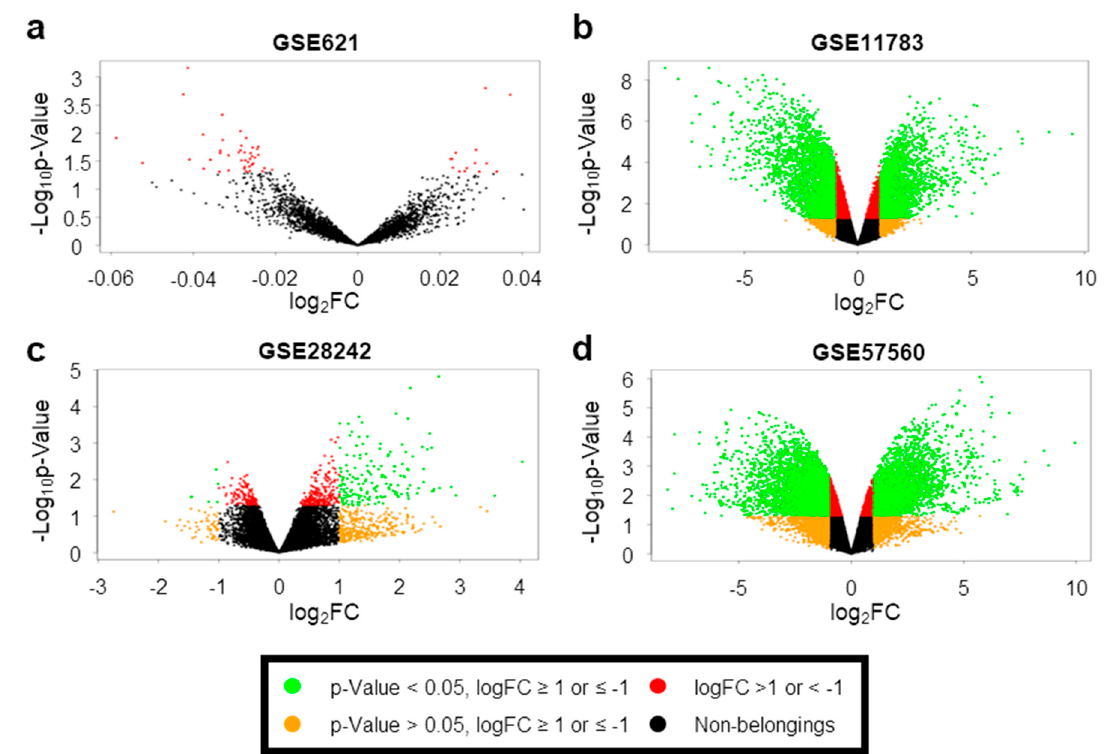
Figure 1. Analysis of significant genes in interstitial cystitis/bladder pain syndrome (IC/BPS). ( a – d ) Volcano plots show the transcript expression between normal and IC/BPS patients. Color indicates each condition (green: p -value < 0.05, logFC ≥ 1 or ≤ − 1; orange: p -value > 0.05, logFC ≥ 1 or ≤ − 1; red: logFC >1 or < − 1; black: non-significant).